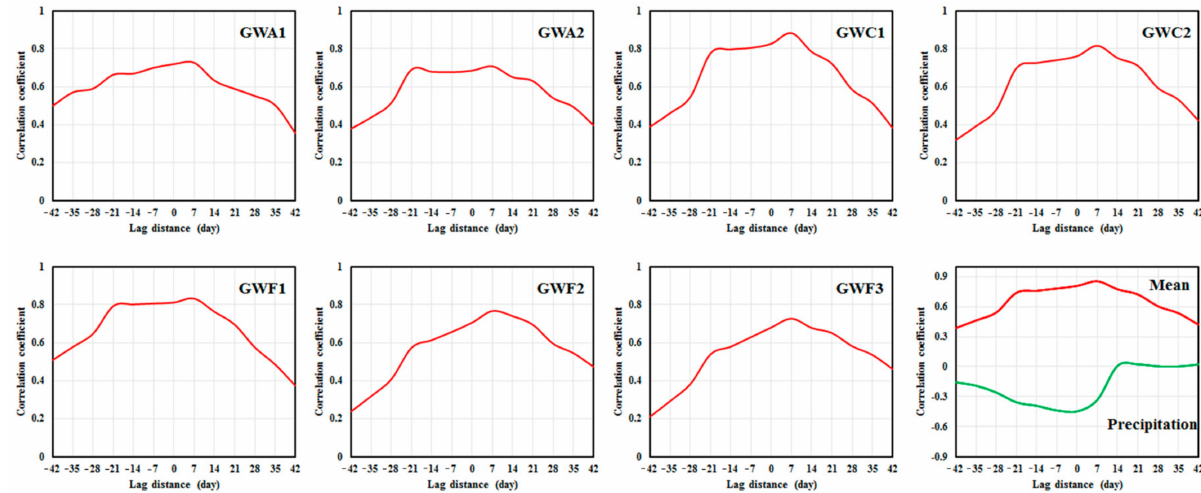
Figure 4. Cross-correlation between the reservoir water level and the groundwater